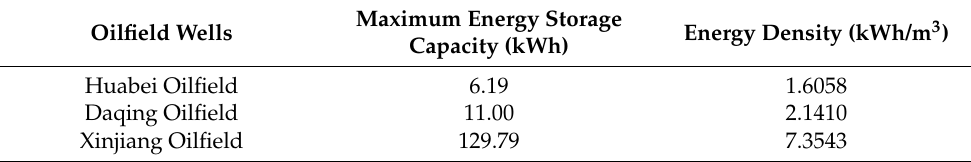
Table 5. Energy storage capacity and energy density of the three major